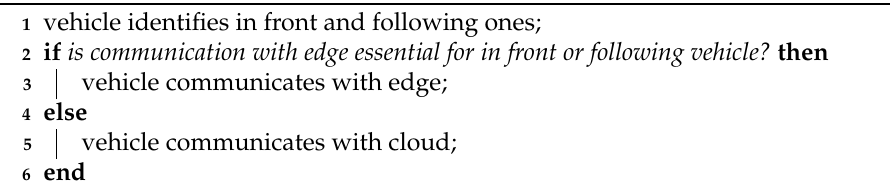
Algorithm 3: Dynamic Switching